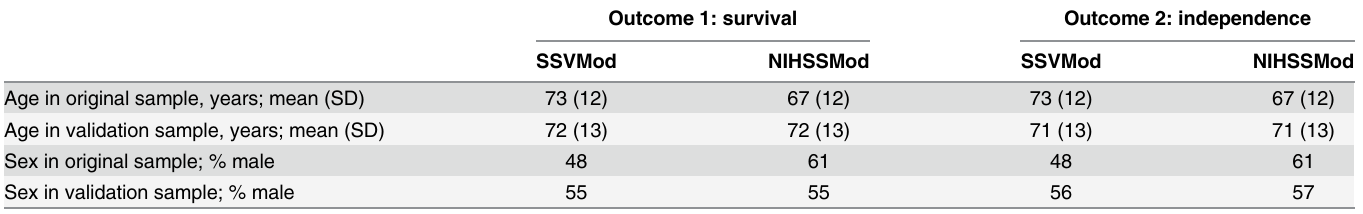
Table 4. Demographic characteristics of the original and validation